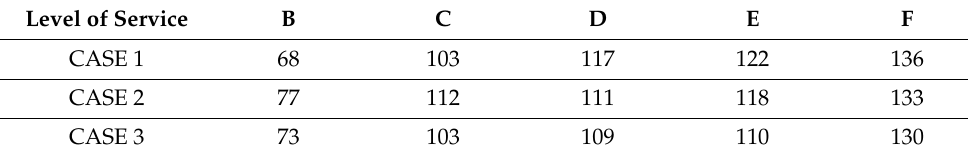
Table 7. NOx emission